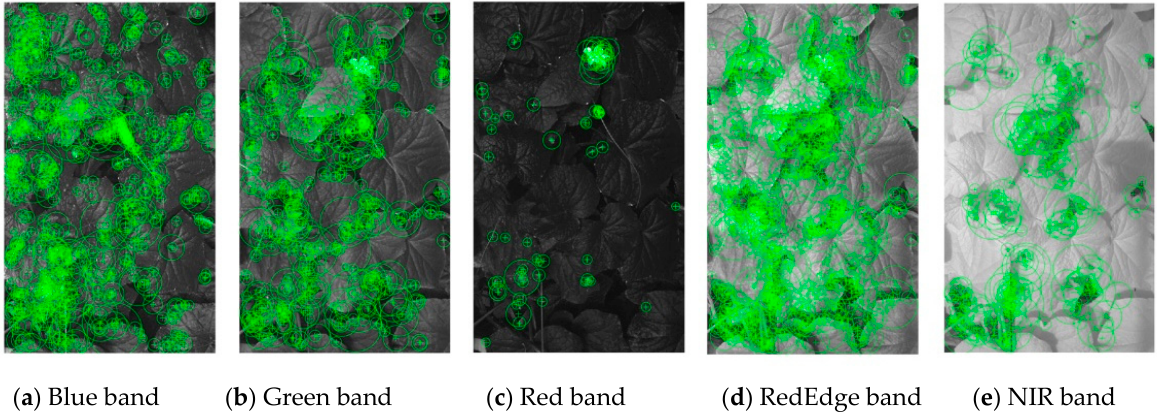
Figure 4. Comparison of the blob-like structures detected over ( a ) blue, ( b ) green ( c ) red, ( d ) RedEdge, and ( e ) NIR band images acquired with a MicaSense ® RedEdge camera at close range over cucumber